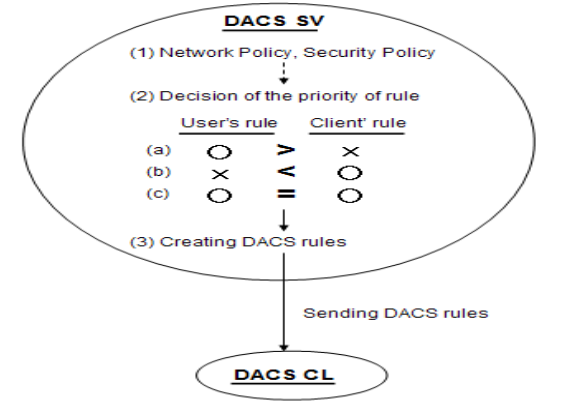
Figure 6. Creating the DACS rules on the DACS